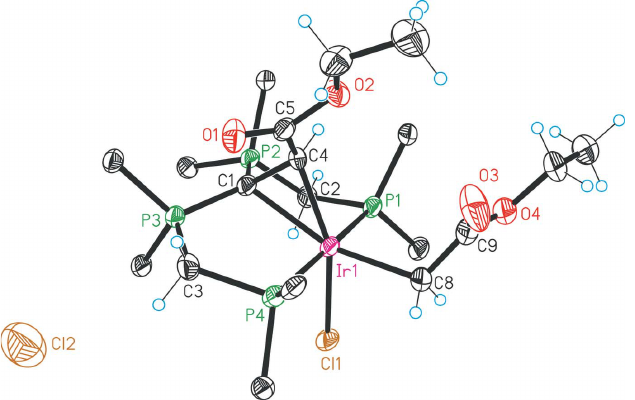
Figure 3 Molecular structure of the complex cation in 5 and the counter-anion. Displacement ellipsoids are drawn at the 30% probability level. For clarity, only the ipso carbon atoms of the phenyl groups are presented and the solvent molecules are omitted.